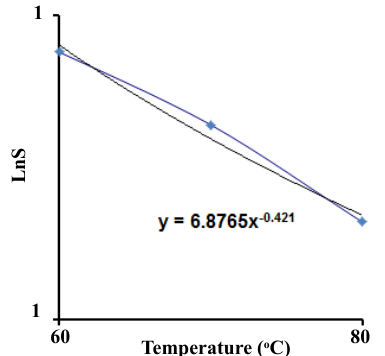
Fig. 6: Temperature effect on the supersaturation variation